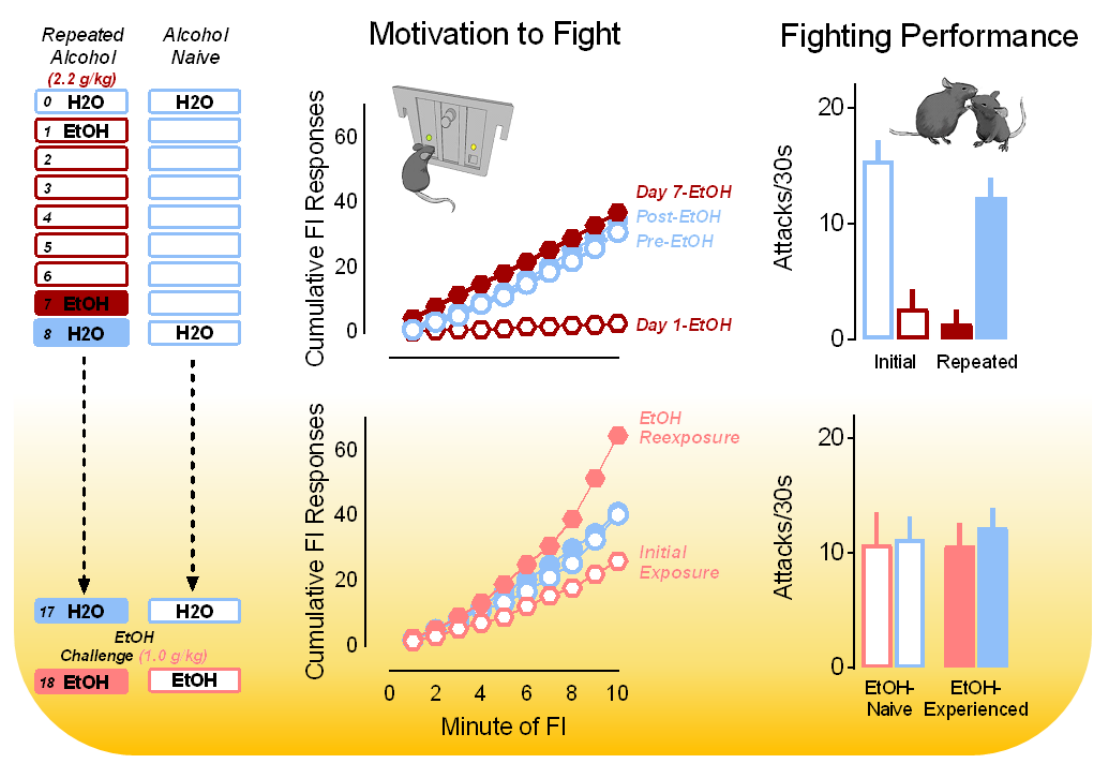
Figure 3. Aggressive motivation escalates with repeated administrations of alcohol and remains persistently sensitized to lower concentrations of alcohol. Fixed interval (FI) response rates (upper middle) are depicted over repeated oral administrations (via gavage) of water or alcohol (2.2 g/kg; top) and 10 days later in response to a dose of water or a low challenge dose of alcohol (1.0 g/kg; bottom middle). Here, the motivation to fight is initially disrupted by alcohol before levels of FI responding recover to baseline. After just seven daily alcohol administrations, the motivation to fight in response to a low dose of alcohol becomes sensitized (bottom middle). Fighting behavior is persistently disrupted over the course of seven consecutive daily administrations of alcohol (2.2 g/kg; upper right) but not significantly affected 10 days later by a challenge dose of alcohol (1.0 g/kg; bottom right). Adapted from Covington et al. 83 with permission from Frontiers Media